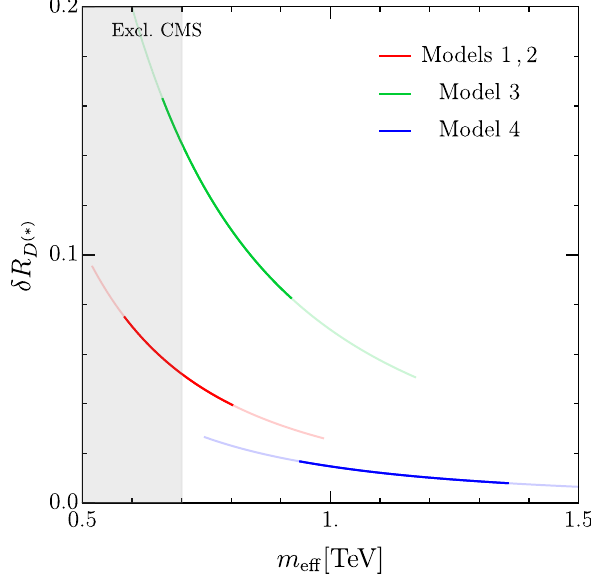
Fig. 2 δ R D ( ∗ ) as a function of m eff varying m eff in the 1 σ (dark) and 2 σ (light)regionpreferredbythefit.Theremainingparametersentering δ R D ( ∗ ) are fixed to the best-fit point. The grey band indicates the CMS exclusion at 700 GeV